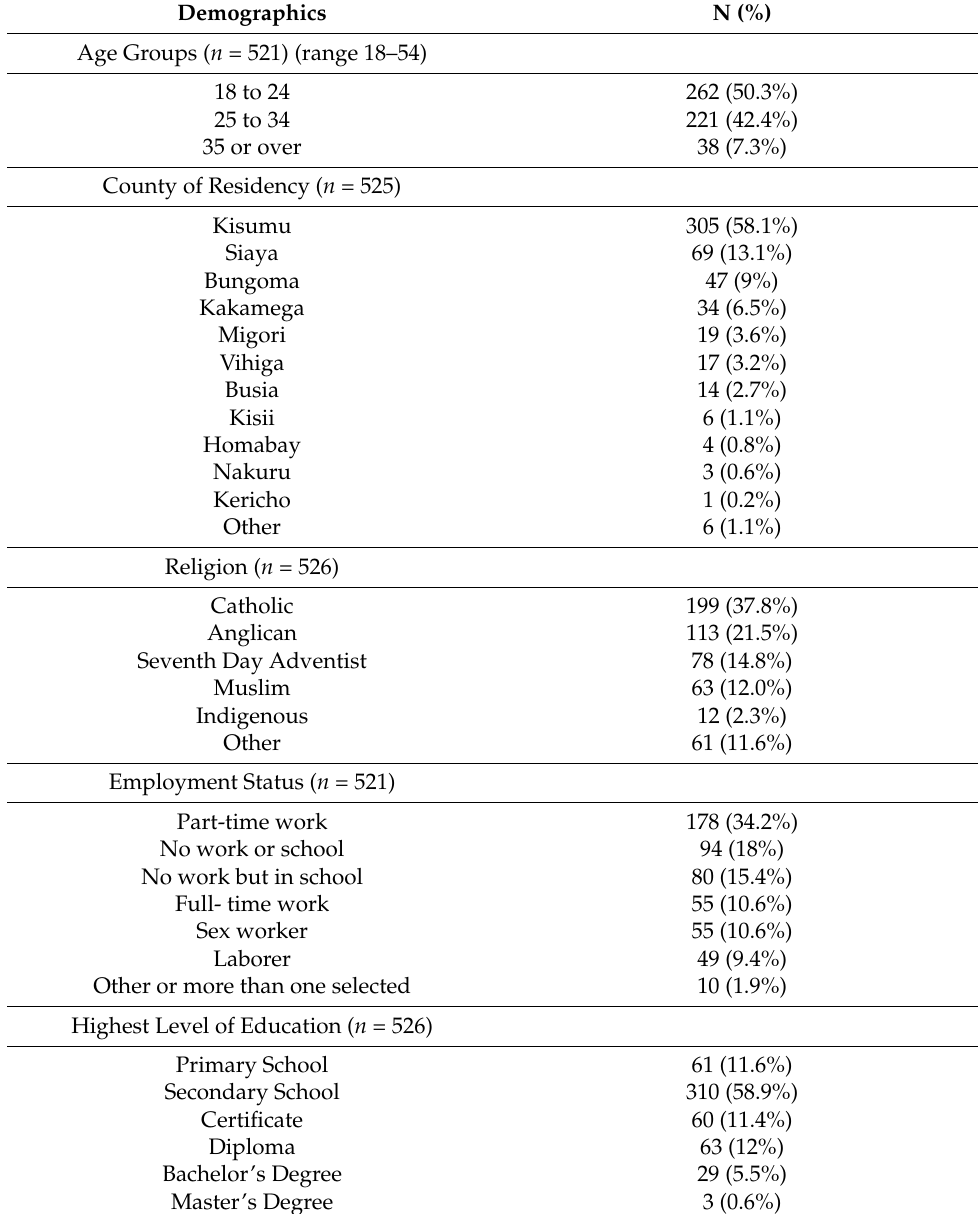
Table 1. Sample General